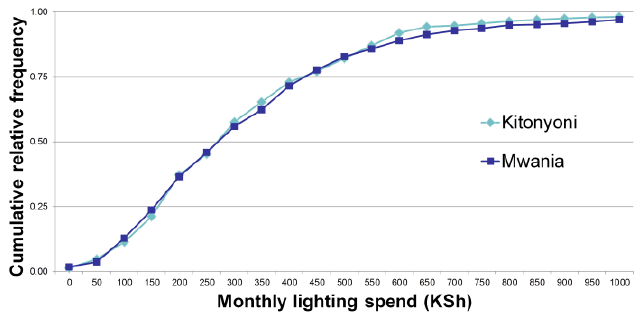
Figure 3. Cumulative distribution of monthly kerosene spend for all households surveyed in 2012 ( n = 1065) with a median of 280 KES for both sub-locations (or ~2.80 USD).